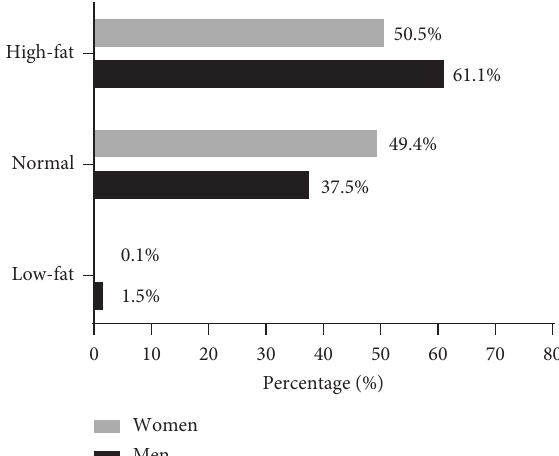
Figure 3: Distribution of the descriptive characteristics of %BF according to the sex of the students. Note . p < 0 . 001, chi-square was used to compare the proportions between women and